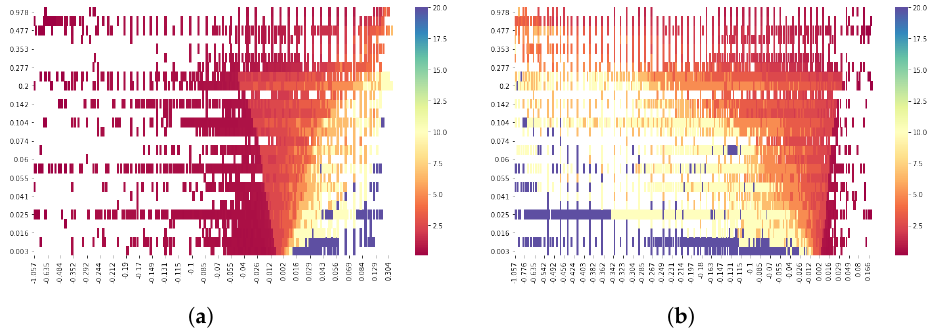
Figure 4. Liquidities by inverse bid-ask spread with traded European options. ( a ) Call; ( b ) Put.